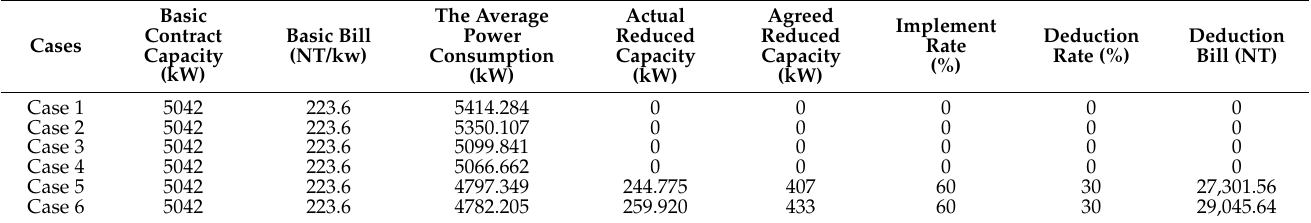
Table 7. The simulation results of 6-h daily reduction model. Table 8. The simulation results of 2-h daily reduction